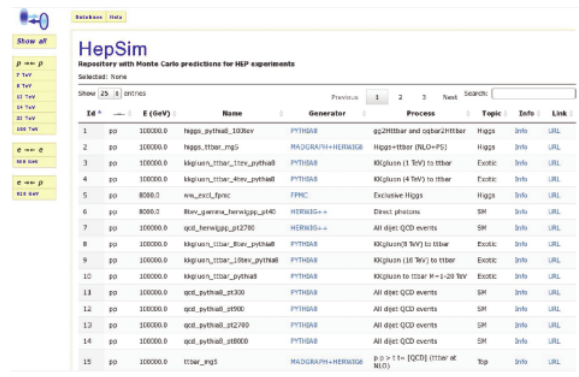
Figure 1: The HepSim front-end to access MC